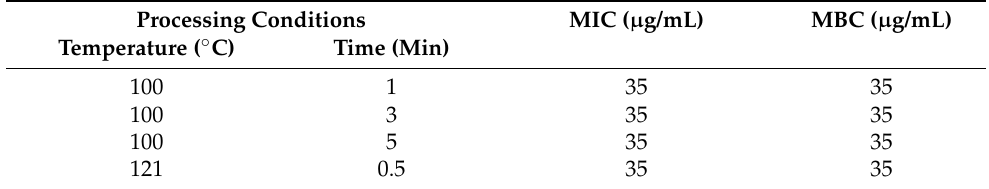
Table 3. MIC and MBC of Shikonin against Staphylococcus aureus (ATCC 29213) strains after heat treatment.